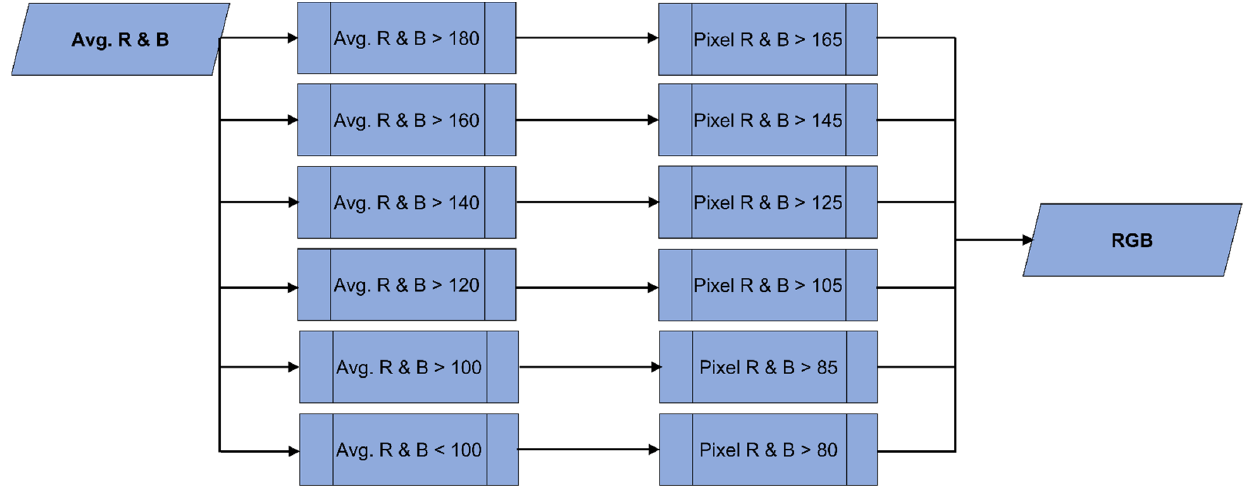
Figure 3. Workflow of step 1: calculations of white pixels using the R and B pixels average values.